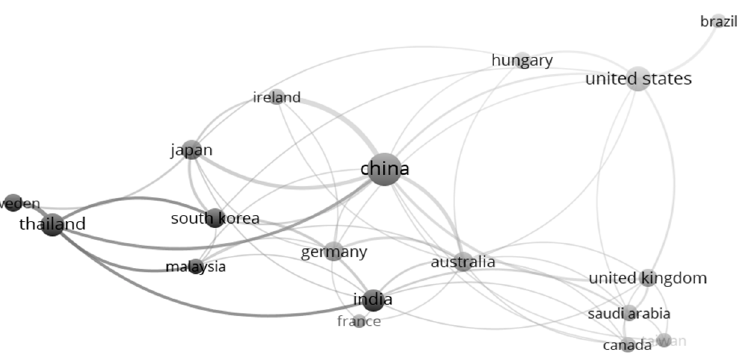
Figure 6. Co-authorship and countries (the size of the node represents the volume of publications, and the line thickness illustrates the term recurrence between the countries).